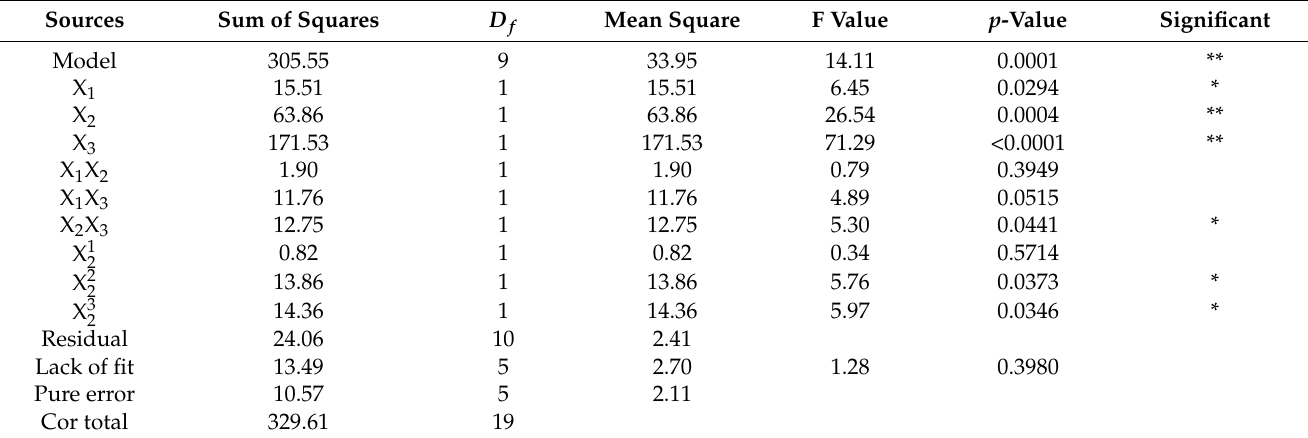
Table 4. Variance analysis.